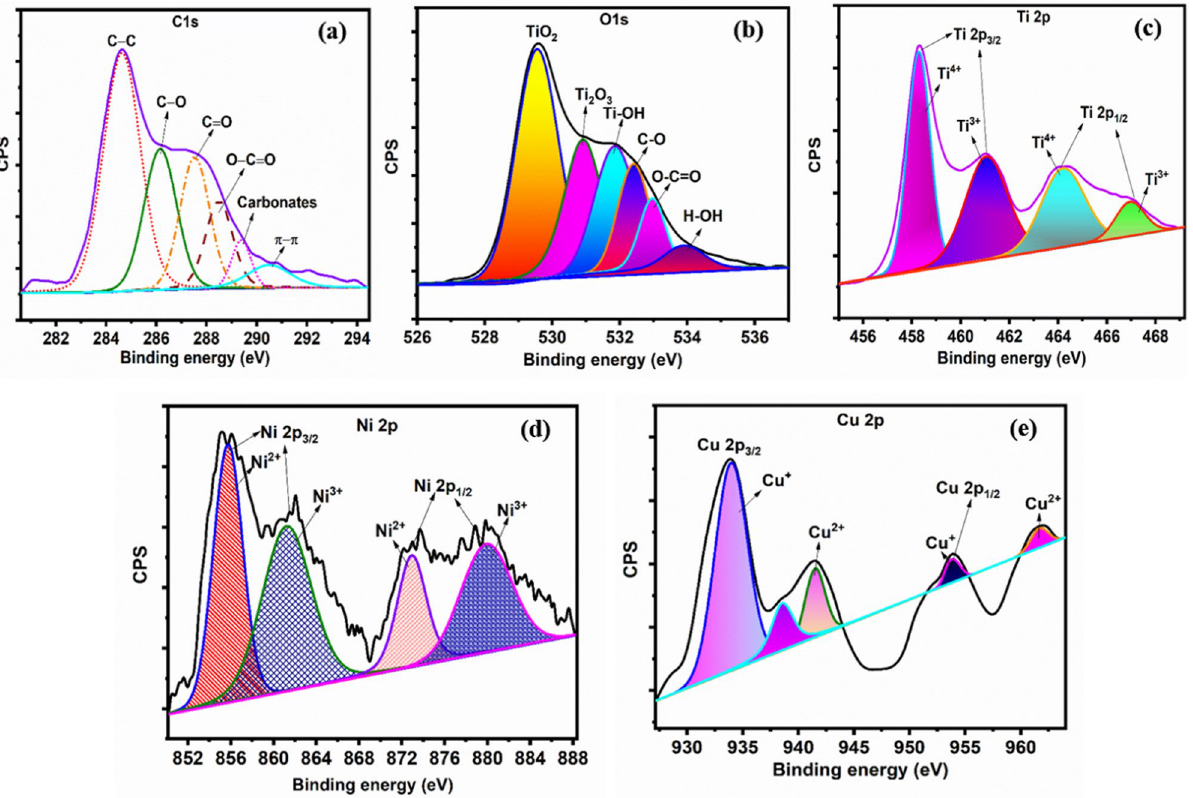
Figure 4. High resolution XPS spectra of Cu/Ni/TiO 2 /MWCNTs nanocomposites ( a ) C 1 s spectra, ( b ) O 1 s spectra, ( c ) Ti 2p spectra, ( d ) Ni 2p spectra, and ( e ) Cu 2p